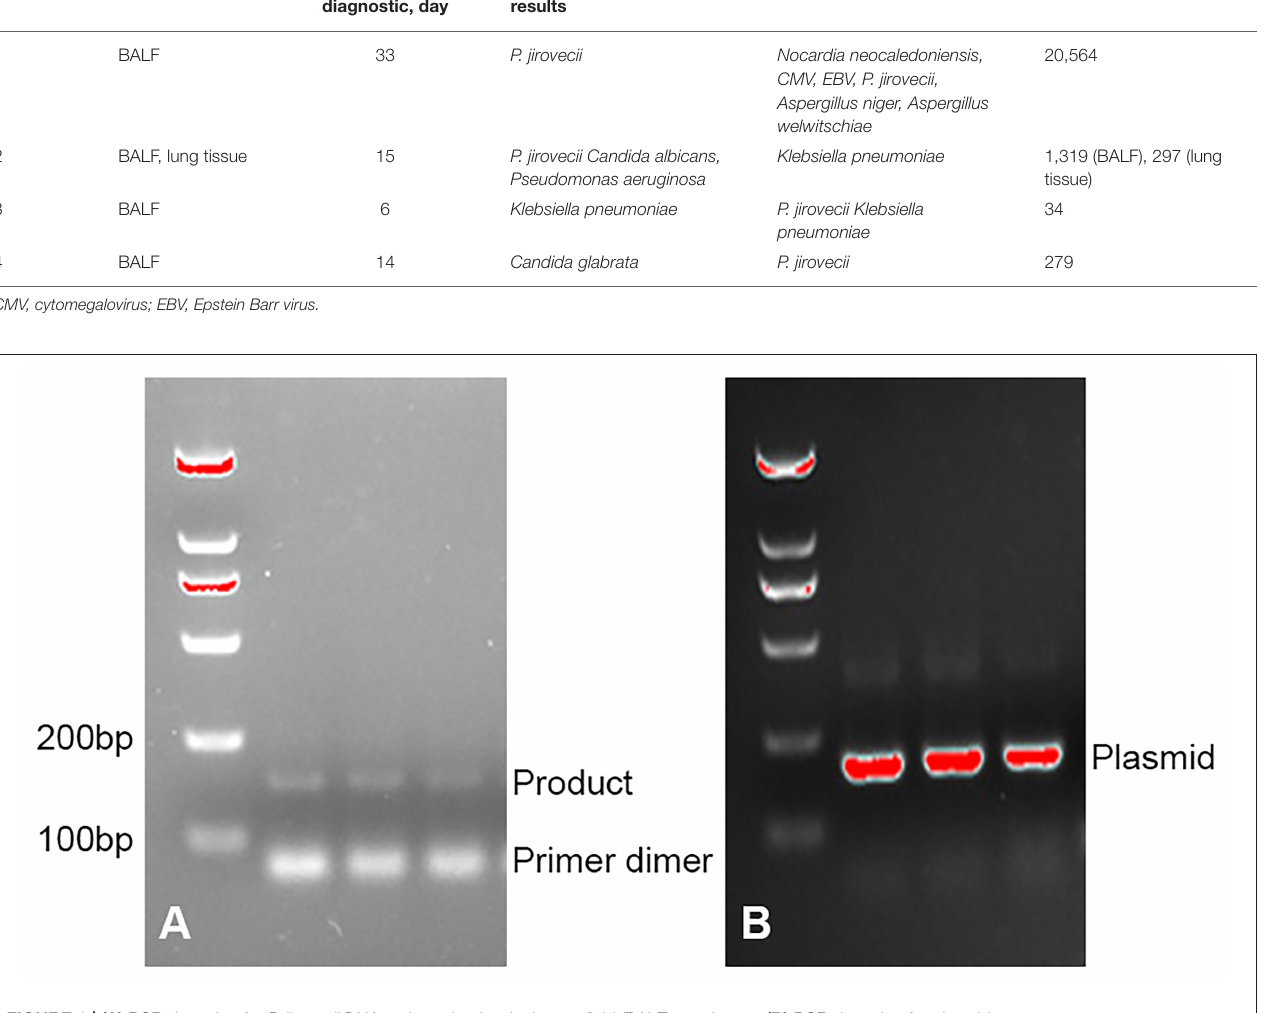
and was given biapenem, voriconazole, gamma globulin,